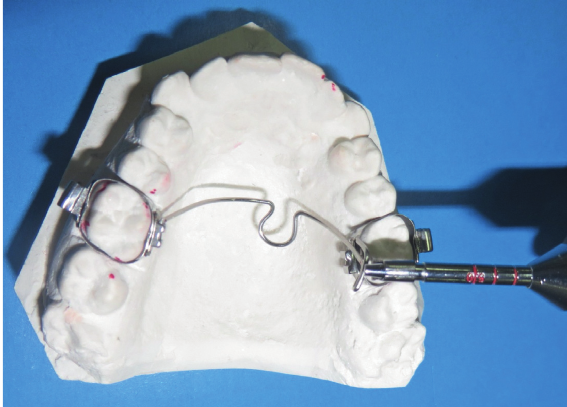
Figure 3: An example of force magnitude